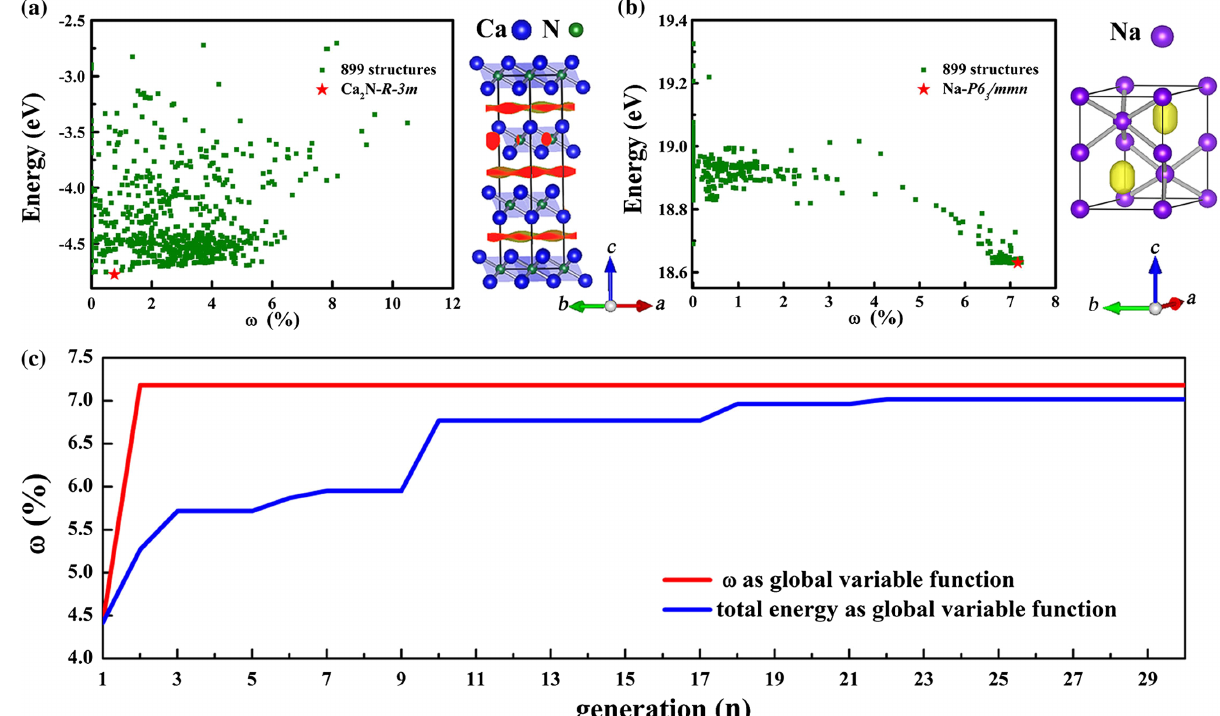
FIG. 2. Benchmarking to two known electrides: Ca 2 N at ambient pressure and transparent Na at 320 GPa. ω versus energy maps of Ca 2 N at ambient pressure (a) and transparent Na at 320 GPa (b). Symbols represent structures produced by the CALYPSO run within 30 generations. The experimental anti-CdCl 2 and hP 4 electride structures for Ca 2 N and Na are shown as red stars in the maps. (c) Evolution of the optimum ω versus generations for Ca 2 N using ω (red line) and total energy (blue line) as global variable functions, respectively. The x axis is the n th generation in an inverse-design simulation by CALYPSO